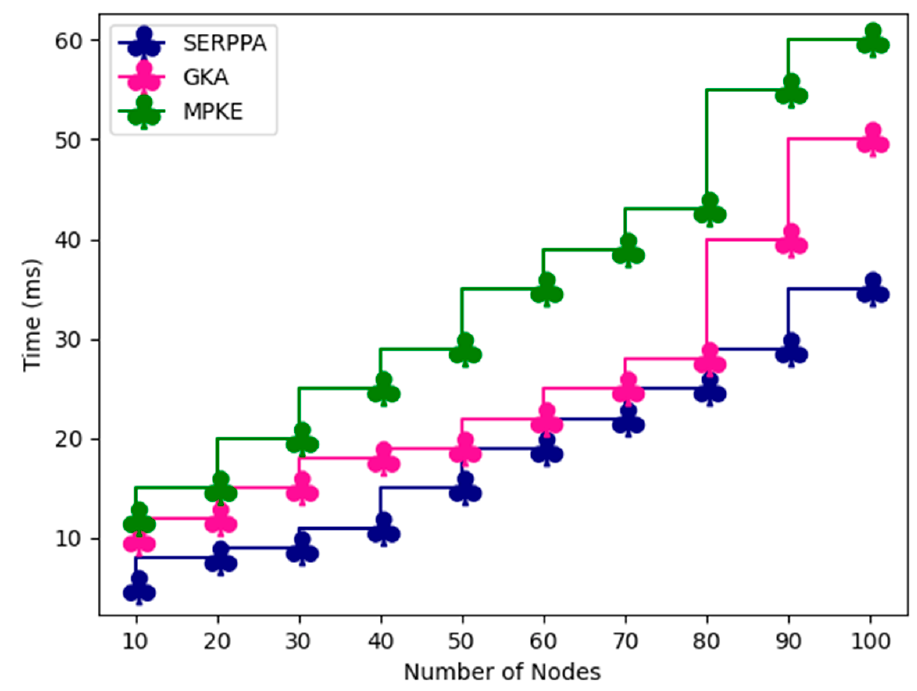
Figure 7. Time consumed vs. number of nodes.